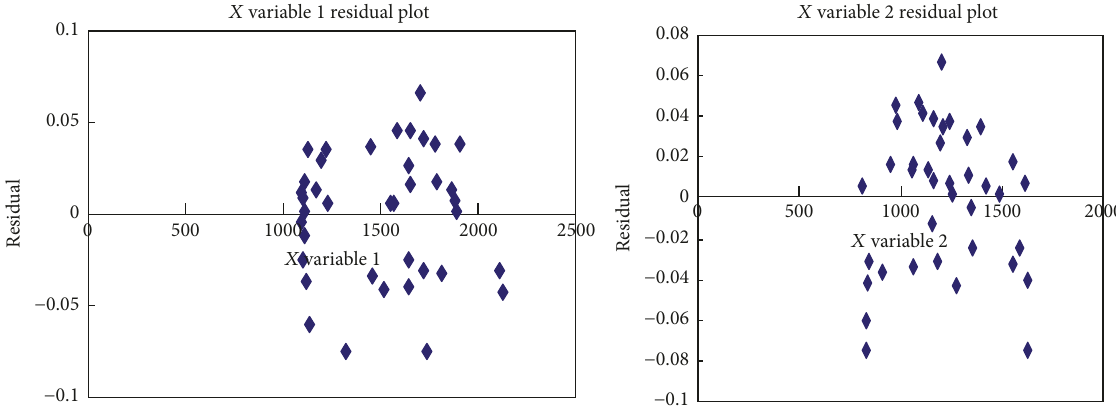
Figure 4: Residual